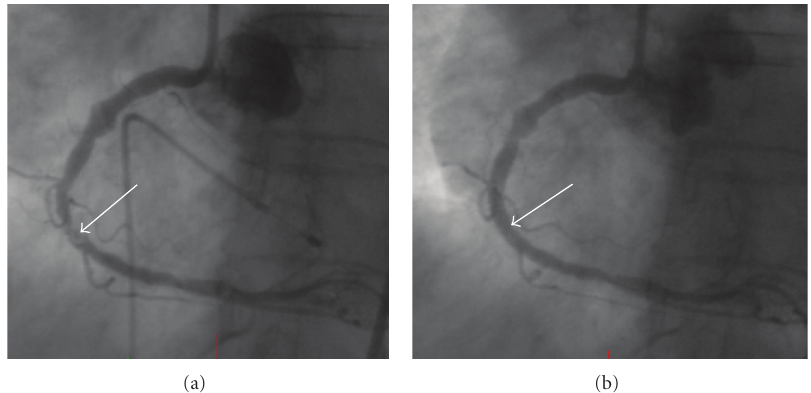
Figure 1: Angiographic images of the right coronary artery with a significant mid-segment calcified stenosis (a) and final result after